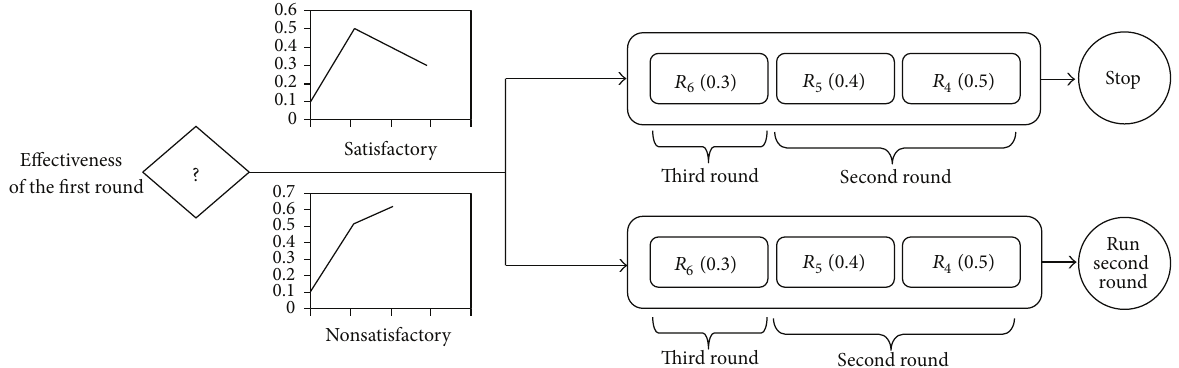
Figure 3: Two possible outcomes for decision-making after running the first round of